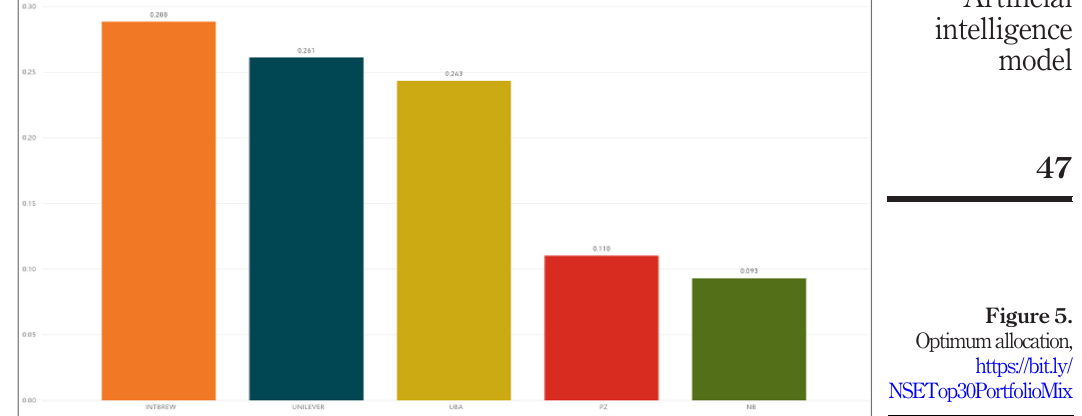
Figure 5. Optimumallocation, https://bit.ly/